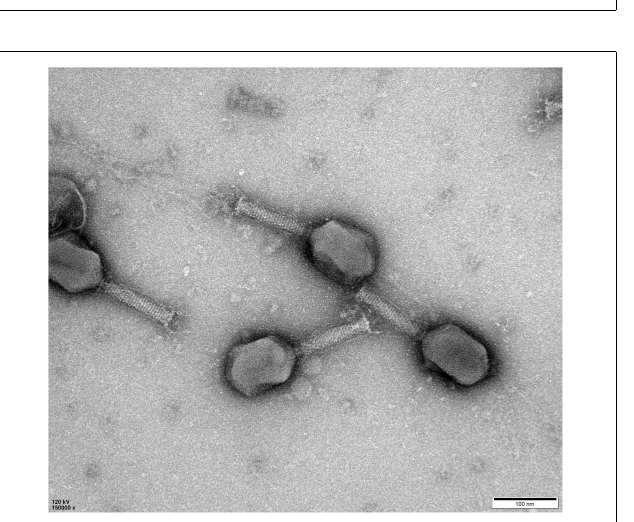
FIGURE 2 | Morphology of phage vB_EaeM_ ϕ Eap-3. Transmission electron micrograph of negatively stained phage vB_EaeM_ ϕ Eap-3 at × 150,000 magnification. The bar indicates 100 nm.